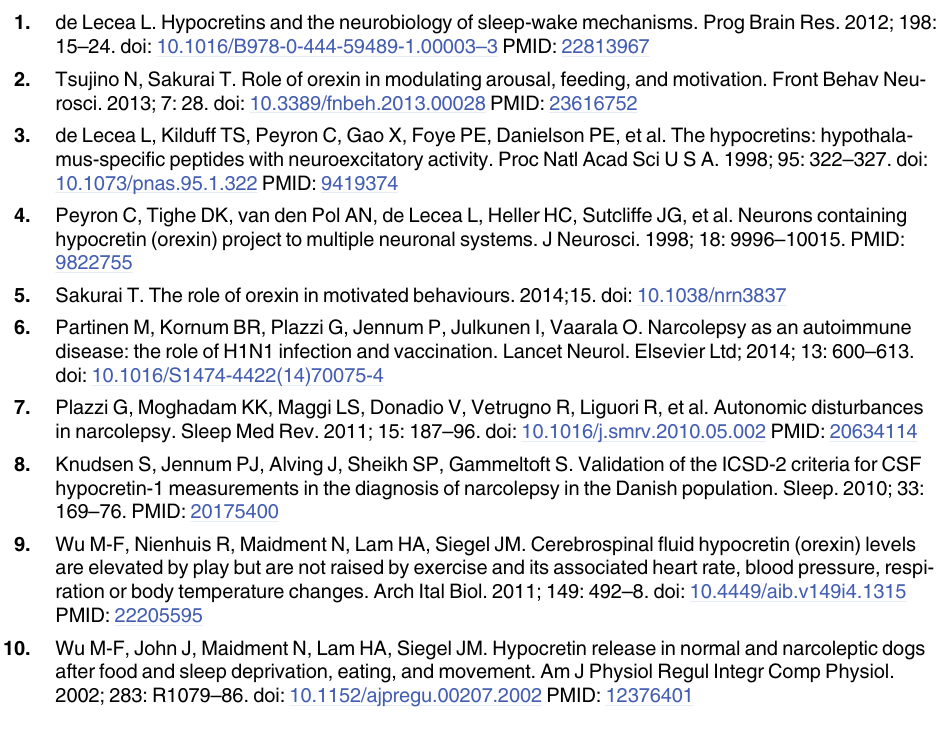
S1 Table. Correlations among climate factors. S2 Table. Summary of Multiple Regression Models including different climate factors. S3 Table. No predictive value of MSLT and PSG data. Summary of Multiple Regression Anal- ysis. S4 Table. No predictive value of leucocyte count. Summary of Multiple Regression Analysis. S5 Table. No predictive value of C-reactive protein level. Summary of Multiple Regression